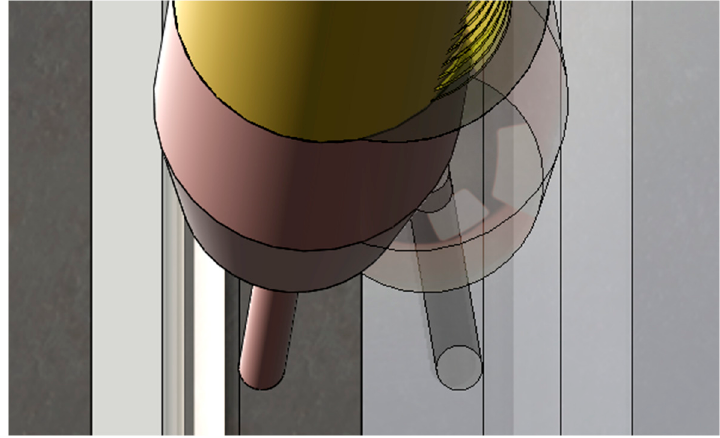
Figure 1. Contact tip and the wire of the self-designed torch.